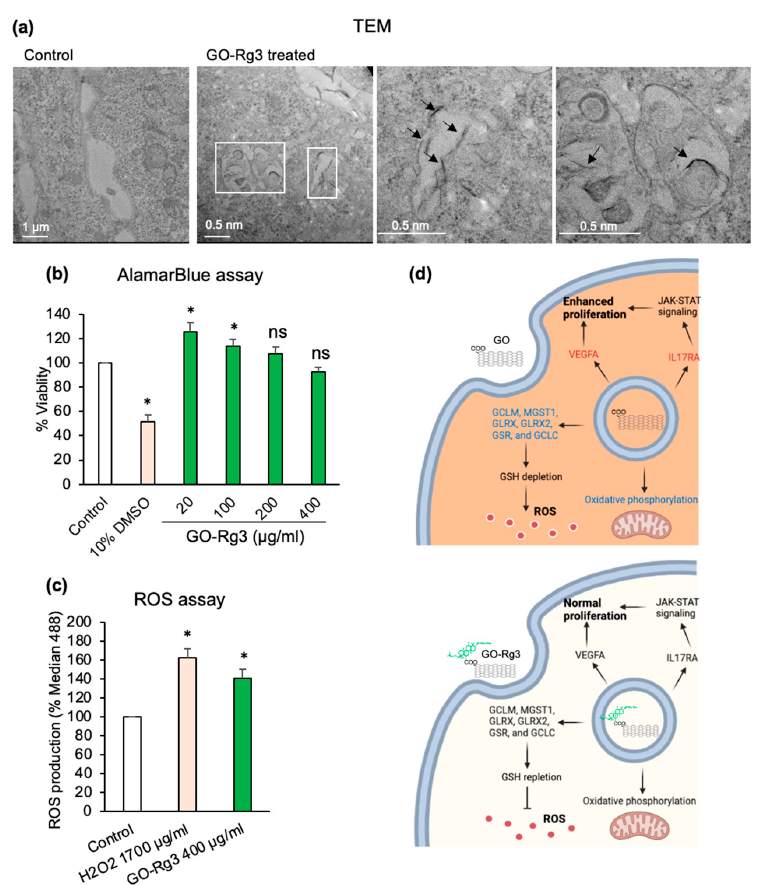
Figure 4. Conjugation of Rg3 with GO reduces oxidative stress induced by the nanocarrier in Huh7 cells. ( a ) TEM images of Huh7 control cells and cells treated with 400 μ g/mL GO for 6 h. Evidence of GO internalization is marked with white boxes, with higher magnification images and black arrows pointing to internalized GO flakes. ( b ) AlamarBlue cell viability assay of Huh7 cells treated with GO–Rg3 for 24 h. GO–Rg3 was prepared using the 0.5 mg/mL solution of Rg3 for loading. Different concentrations of GO–Rg3 were administered. All values were normalized to those obtained from untreated cells (medium only). The positive control was 10% DMSO. ( c ) ROS production induced by 24 h exposure of Huh7 cells to 400 μ g/mL GO–Rg3. ROS was measured at excitation at 488 nm on a flow cytometer based on the formation of the fluorescent compound 2 ′ ,7 ′ -dichloro- fluorescein (DCF) in presence of ROS. Median 488 values represent DCF fluorescent signal and are normalized to the signal from untreated cells. H 2 O 2 was used as a positive control. ( d ) Schematic model of GO (Top) and GO–Rg3 (Down) internalization into Huh7 cells and downstream effects. (Top) GO internalized through endocytosis, under-expressed oxidative phosphorylation, and glu- tathione-biosynthesis-related genes, leading ROS accumulation. GO enhances cell proliferation through upregulation and activation of JAK-STAT signaling and VEGF. (Down) GO–Rg3 mitigates toxicity of GO by restoring the expression level of oxidative phosphorylation and glutathione bio- synthesis genes, leading to reduced ROS production. GO–Rg3 moderates the expression of JAK- STAT signaling and VEGF, leading to normal cell proliferation. Red- and blue-colored genes were over- and under-expressed, respectively, while black means unchanged expression. Relevant to panel B and C, data represent the mean ± SE of three independent replicates and it was statistically analyzed and compared with the control (*: p < 0.05, ns: not significant) using Student’s t test.